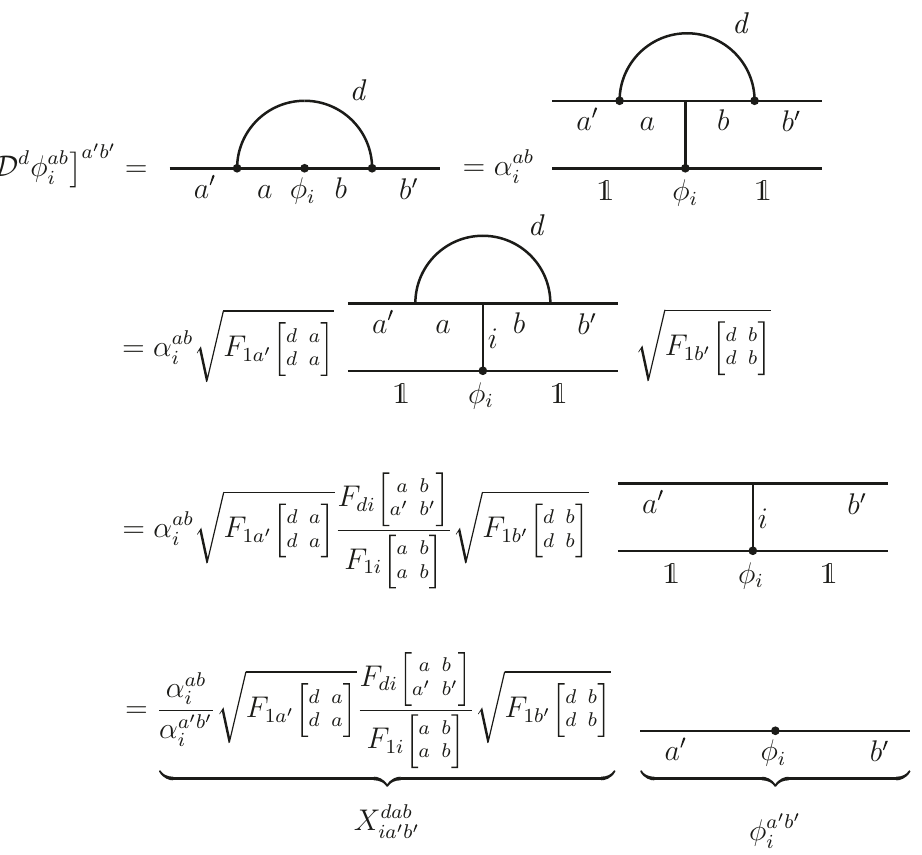
. Notice that ia ′ b ′